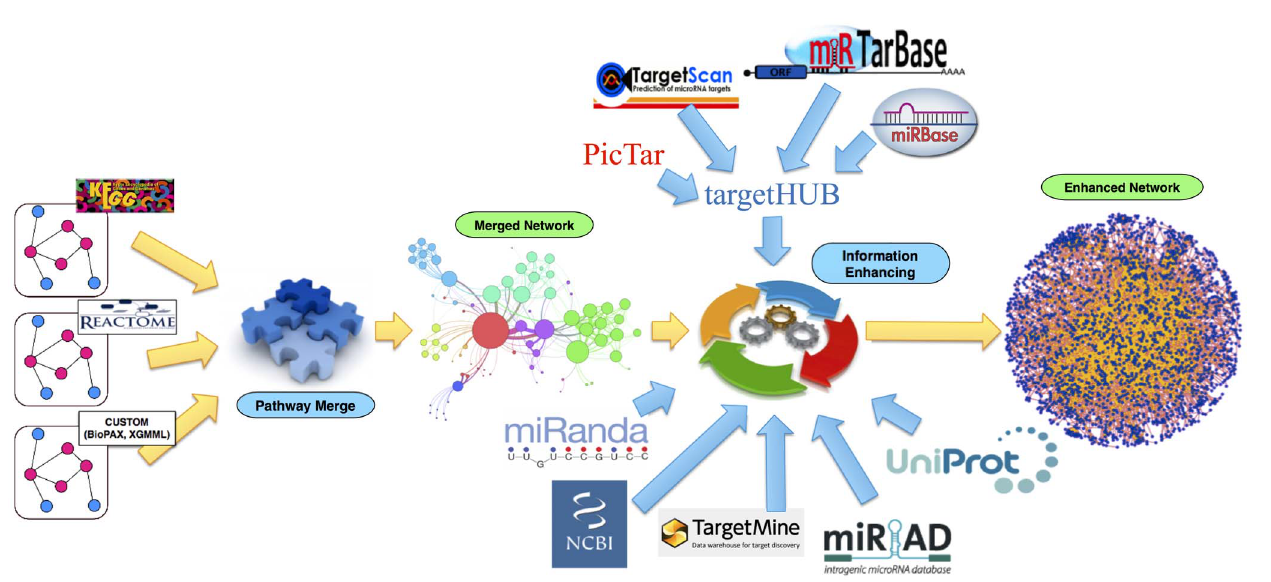
Fig. 1. The ReNE data flow. KEGG, Reactome or custom pathways are retrieved and merged obtaining a merged network. The merged network is enhanced with information retrieved from multiple public repositories (i.e., miRIAD, TargetMine, miRanda, NCBI, UniProt, TargetHUB, PicTar, miRTarBase, TargetScan, miRBase). After the integration of all the new information, the resulting Enhanced Network is eventually